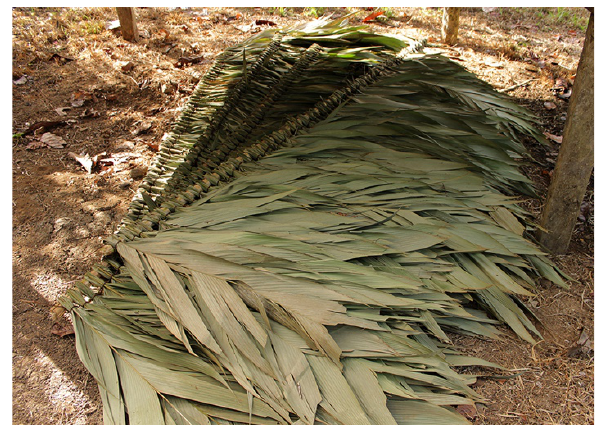
Figure 13. Esteras made with suita leaves, in Bribri area.